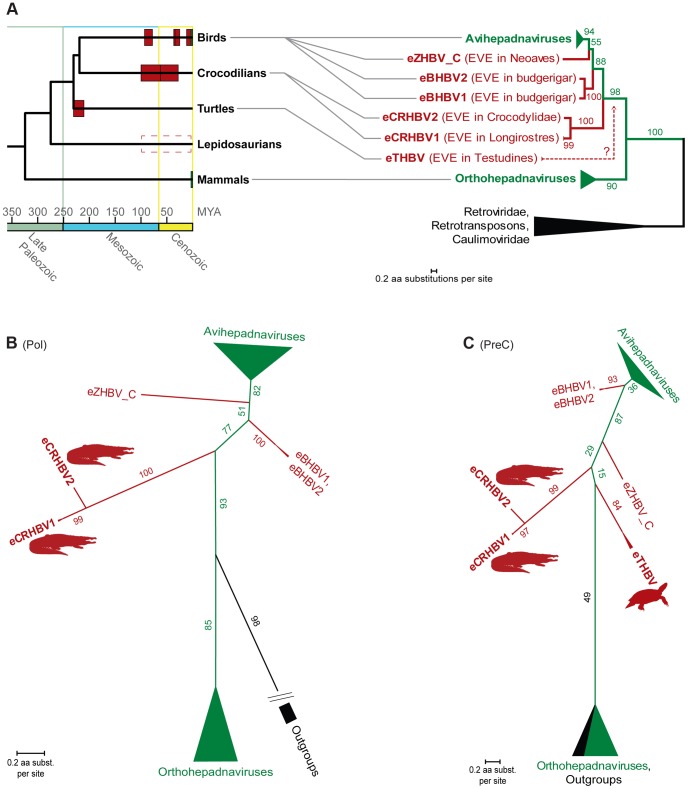
Phylogeny of Hepadnaviridae and their amniote hosts.(A) Plotting the HBV endogenization events (red boxes) reconstructed in this study and ref. [10] on a dated [40] consensus phylogeny of amniotes [27], [30] suggests temporary Mesozoic coexistence of Hepadnaviridae with birds, crocodilians, and turtles, respectively. Extant coexistence with birds and mammals is denoted by green boxes and the undated evidence for snake HBV endogenization events is indicated by a dashed box. The rooted (A) and unrooted (B) phylograms (see S4 Figure for phylograms including the short fragments of eSNHBV1 and eSNHBV2) of a maximum likelihood (ML) analysis of the polymerase protein from hepadnaviruses and reverse-transcribing outgroups (caulimoviruses, retroviruses and retrotransposons) exhibit a phylogenetic placement of crocodilian eHBVs that recapitulates the deep phylogeny of their amniote hosts. The precore/core protein ML phylogram (C) on the same ingroup sampling (plus eTHBV) topologically indicates a bird+crocodilian grouping, too, as well as an affinity of these HBVs to the turtle eHBV. Nevertheless, the resolution of the PreC protein on deep HBV relationships remains limited as suggested by low bootstrap support of some internodes and different topologies with regards to the outgroup (i.e., grouping them within Orthohepadnaviruses) as well as the branching order of avian eHBVs. ML bootstrap values are shown in % on respective nodes. Note the long internodes leading to non-avian eHBV branches; these further support the distinctiveness of the protein sequences of these ancient hepadnaviral lineages. All ML trees were generated via RAxML 7.4.7 [76] using the JTT+G model and 1000 bootstrap replicates.